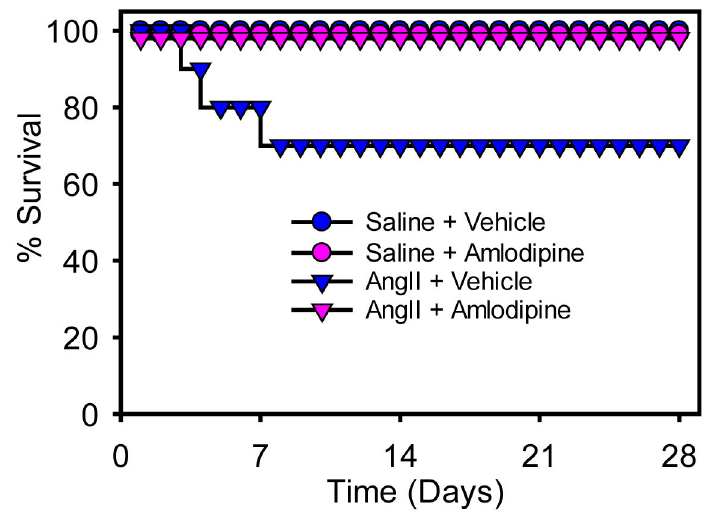
Figure 2. Survival curve for study mice. The survival curve for the four groups of mice during the infusion interval. Mice infused with AngII + vehicle had 3 deaths (occurred on days 3, 4, and 8) due to aortic rupture, while no deaths occurred in the other groups. doi: